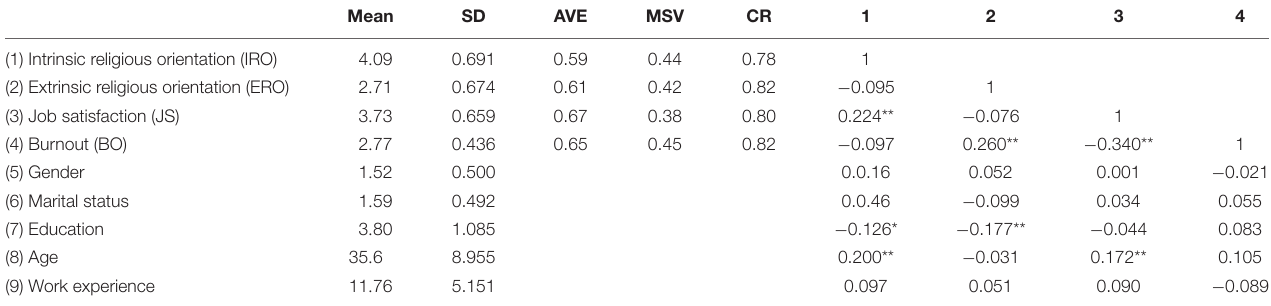
TABLE 1 | Descriptive statistics.